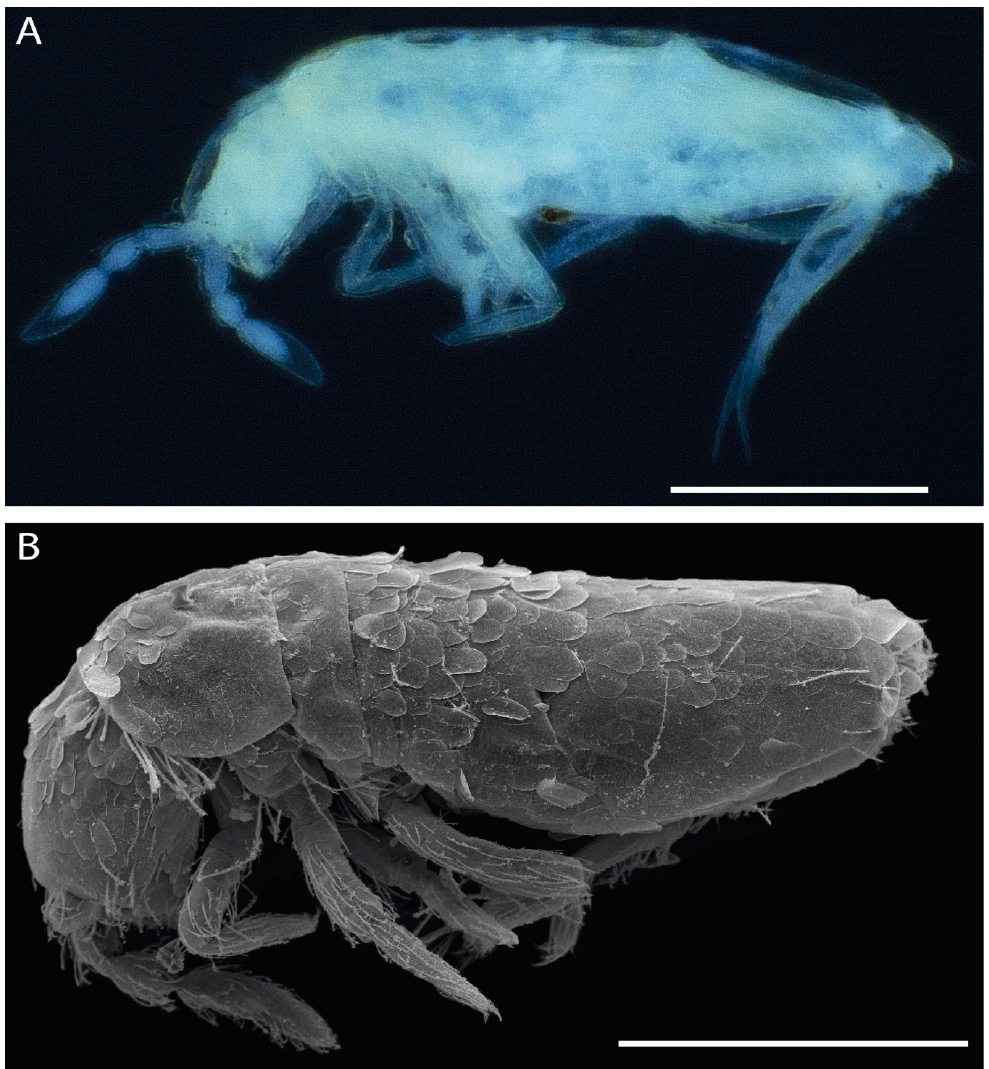
Figure 2. Pseudosinella spp.: habitus in lateral view. ( A ) specimen fixed in ethanol; ( B ), metalized specimen. Scale bars: 0.2 mm.